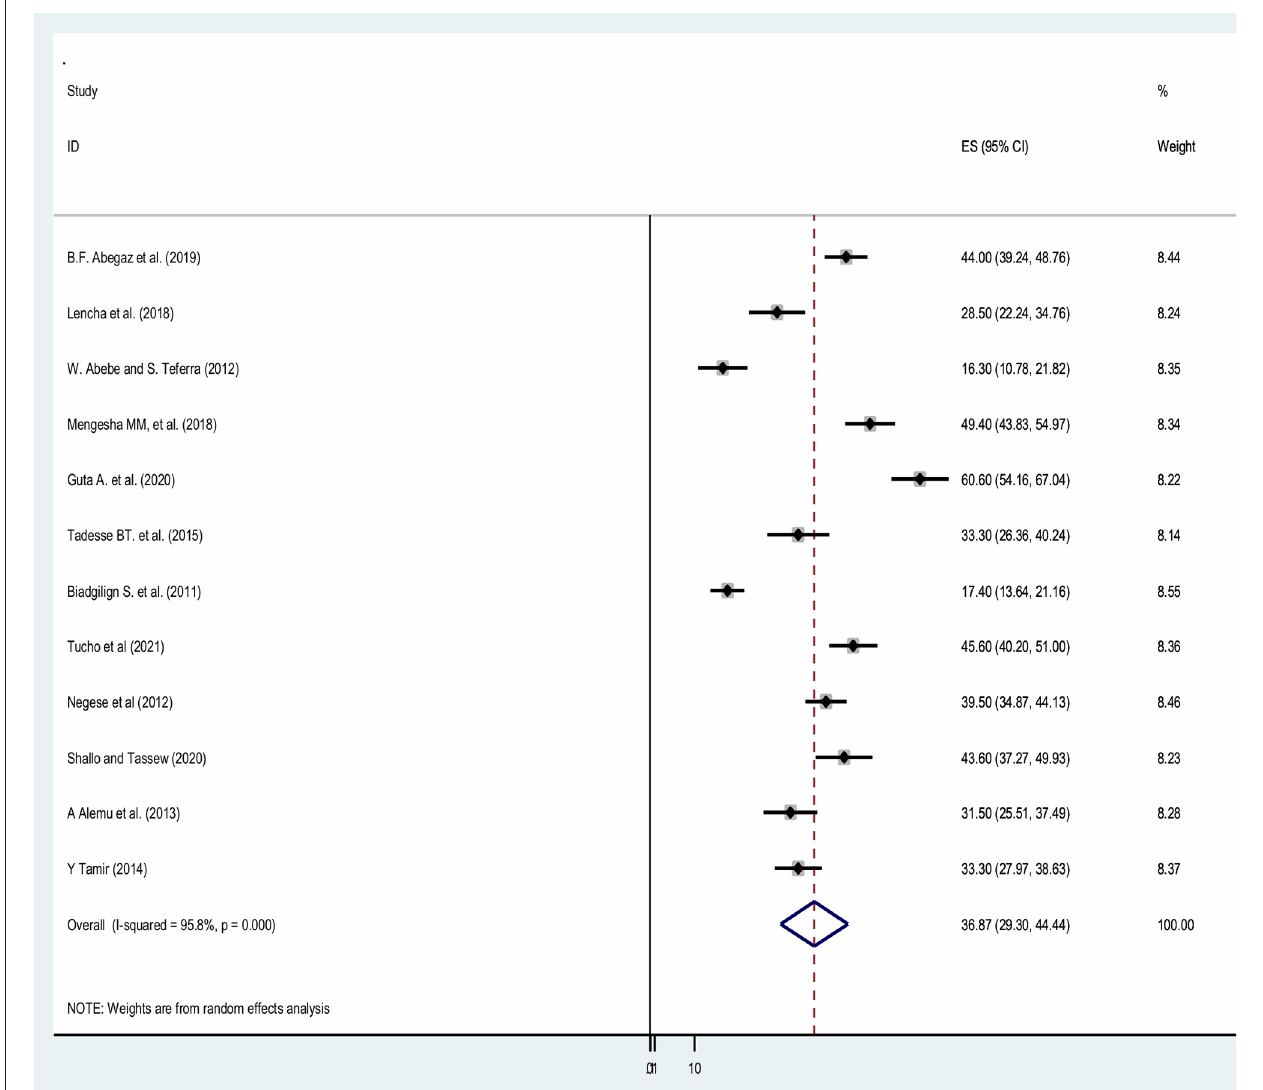
FIGURE 2 | Forest plot showing the pooled prevalence of HIV serostatus disclosure among children in Ethiopia.